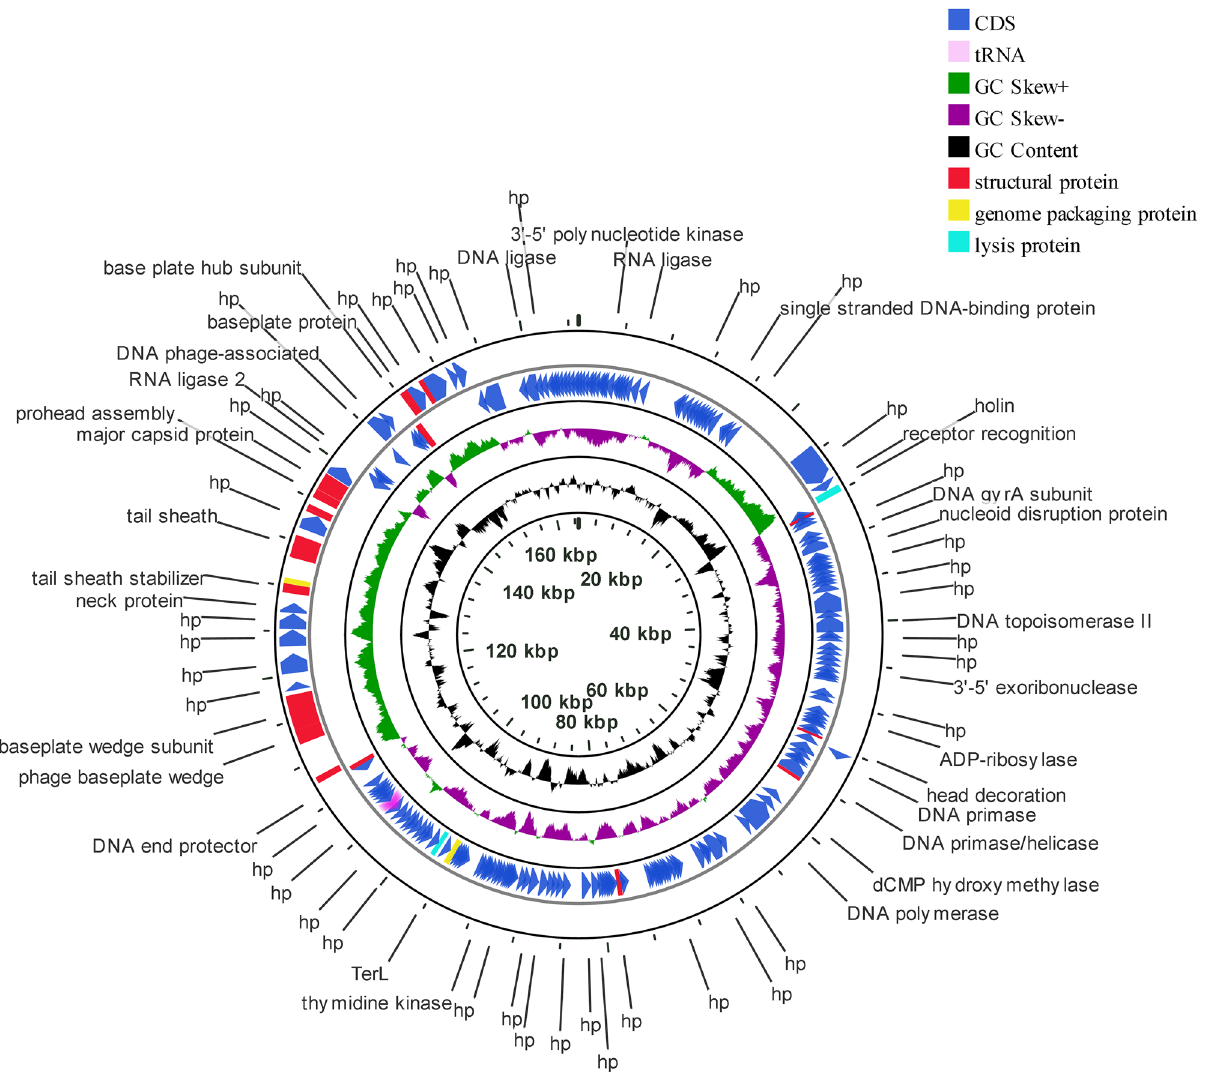
Figure 6. Schematic map of phage Sfk20 genome prepared using CGView. Outer ring represents coding sequence locations (CDS) in blue color; tRNA was marked in pink color. Hypothetical proteins were denoted as hp. The different functional ORFs were indicated in different colors. Red ORFs represent the structural proteins, yellow ORFs represent the genome packaging proteins and the cyan ORFs represent lysis